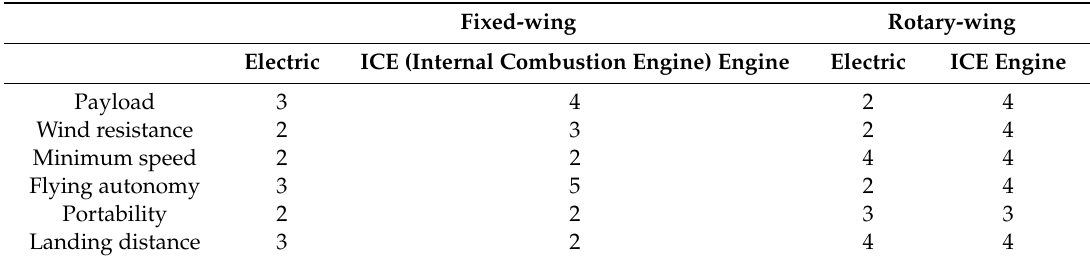
Table 4. Evaluation of some UAV (unmanned aerial vehicle) platforms, according to the literature [46–48] and the authors’ experience. The evaluation is from 1 (low) to 5 (high).